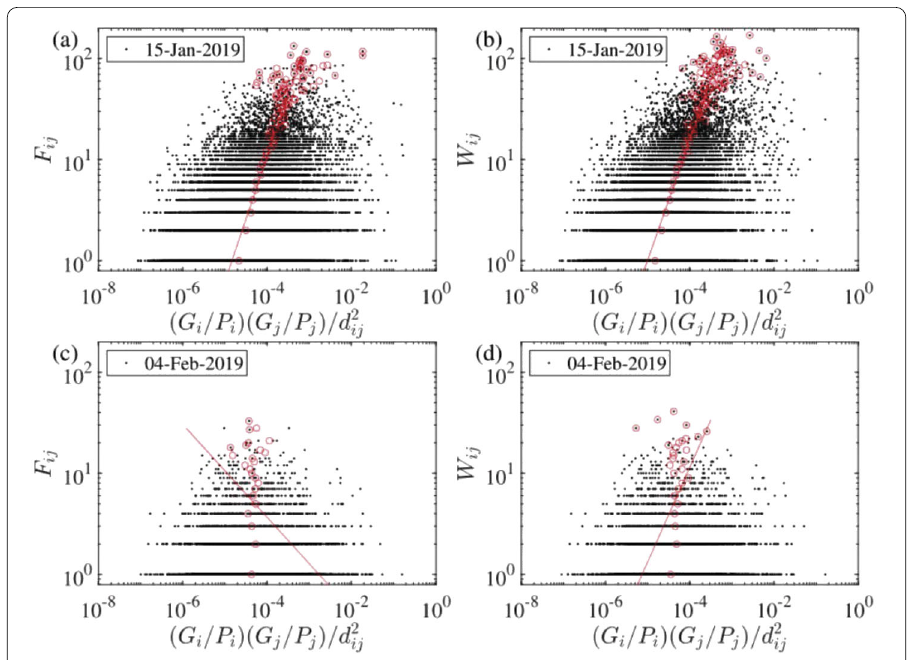
Figure 8 Testing the traditional gravity law with per capita GDP for the daily directed and undirected freight highway transportation networks. ( a ) The directed network on 15 January 2019. ( b ) The directed network on 15 January 2019. ( c ) The directed network on 4 February 2019. ( d ) The undirected network on 4 February 2019